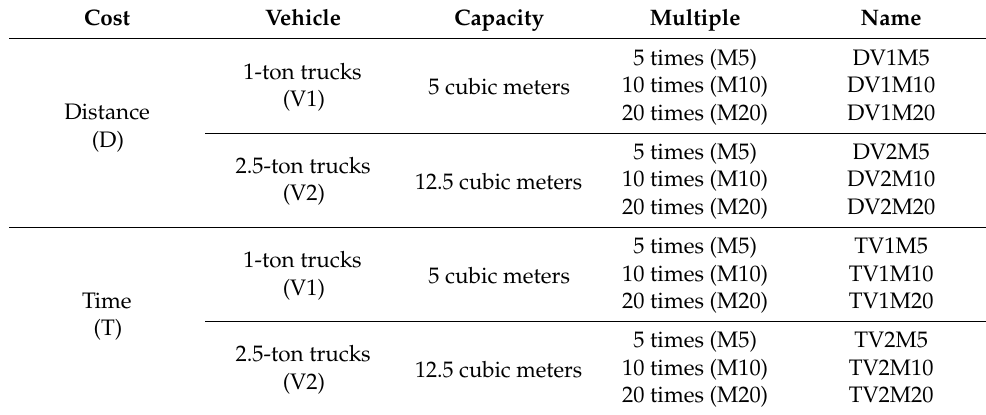
Table 3. Options for varying proposed benchmark